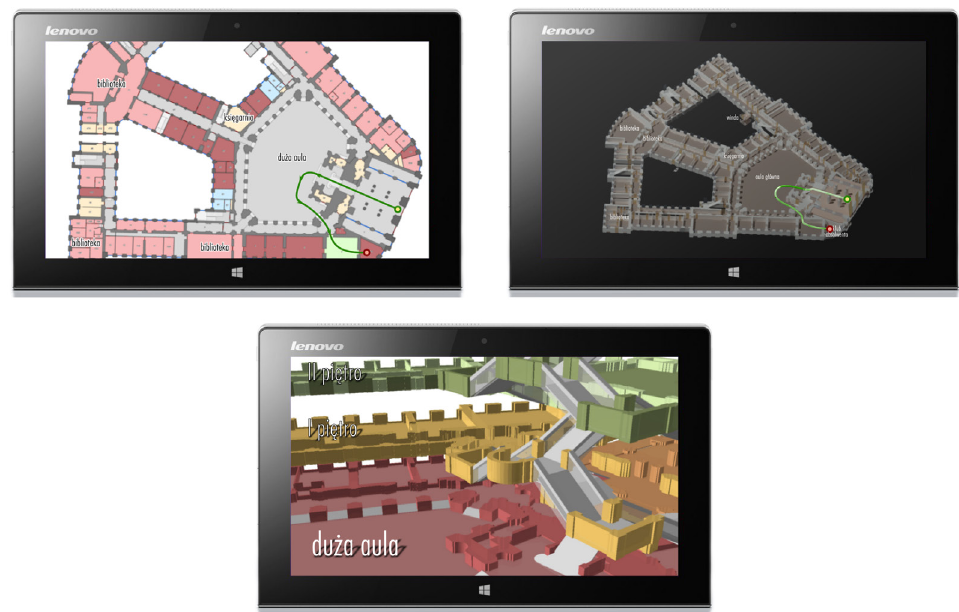
Fig. 4. The example of indoor presentation in 2D and 3D (prototype of the spatial information system of the Warsaw University of Technology) (author’s elaboration after M. Gnat’s